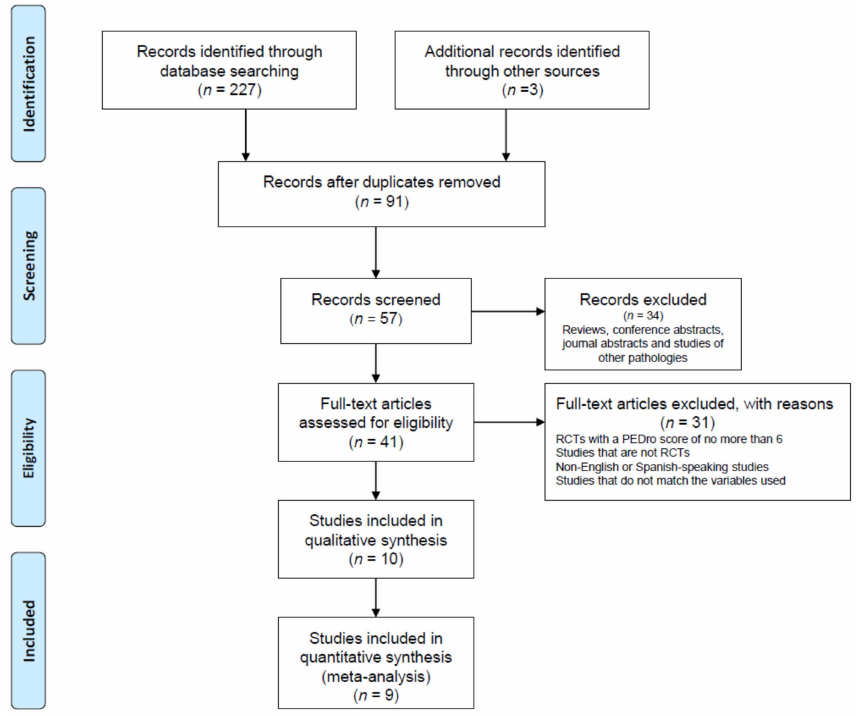
Figure 1. PRISMA flow